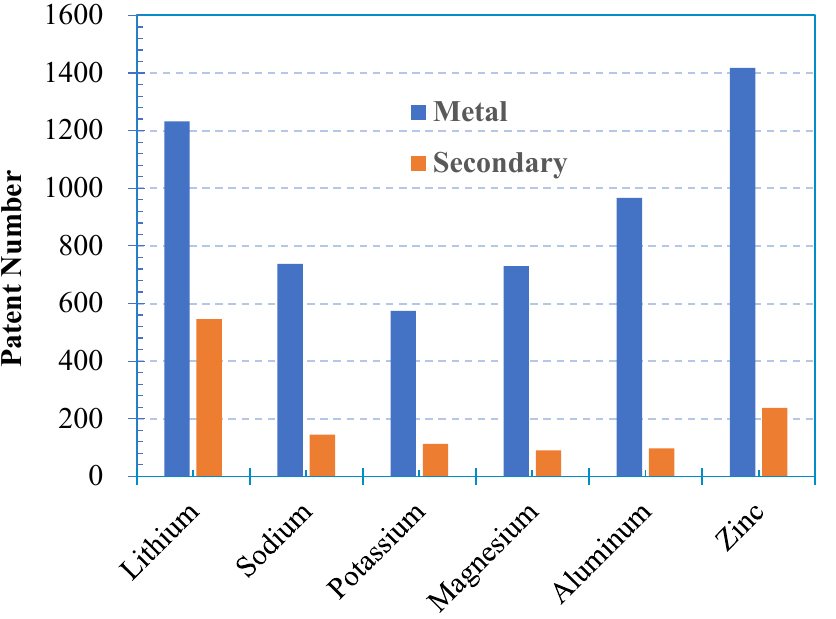
Figure 1. Number of metal–air battery patents filed. Patent search range: TAC, Title/Abstract/Claims. Lithium–air battery search keyword: (metal-air battery) AND (lithium) AND (secondary OR rechargeable); Sodium–air battery search keyword: (metal-air battery) AND (sodium) AND (secondary OR rechargeable); keywords for other metal–air batteries follow a similar searching criterion. The AND and OR are logic operator employed during patent search.